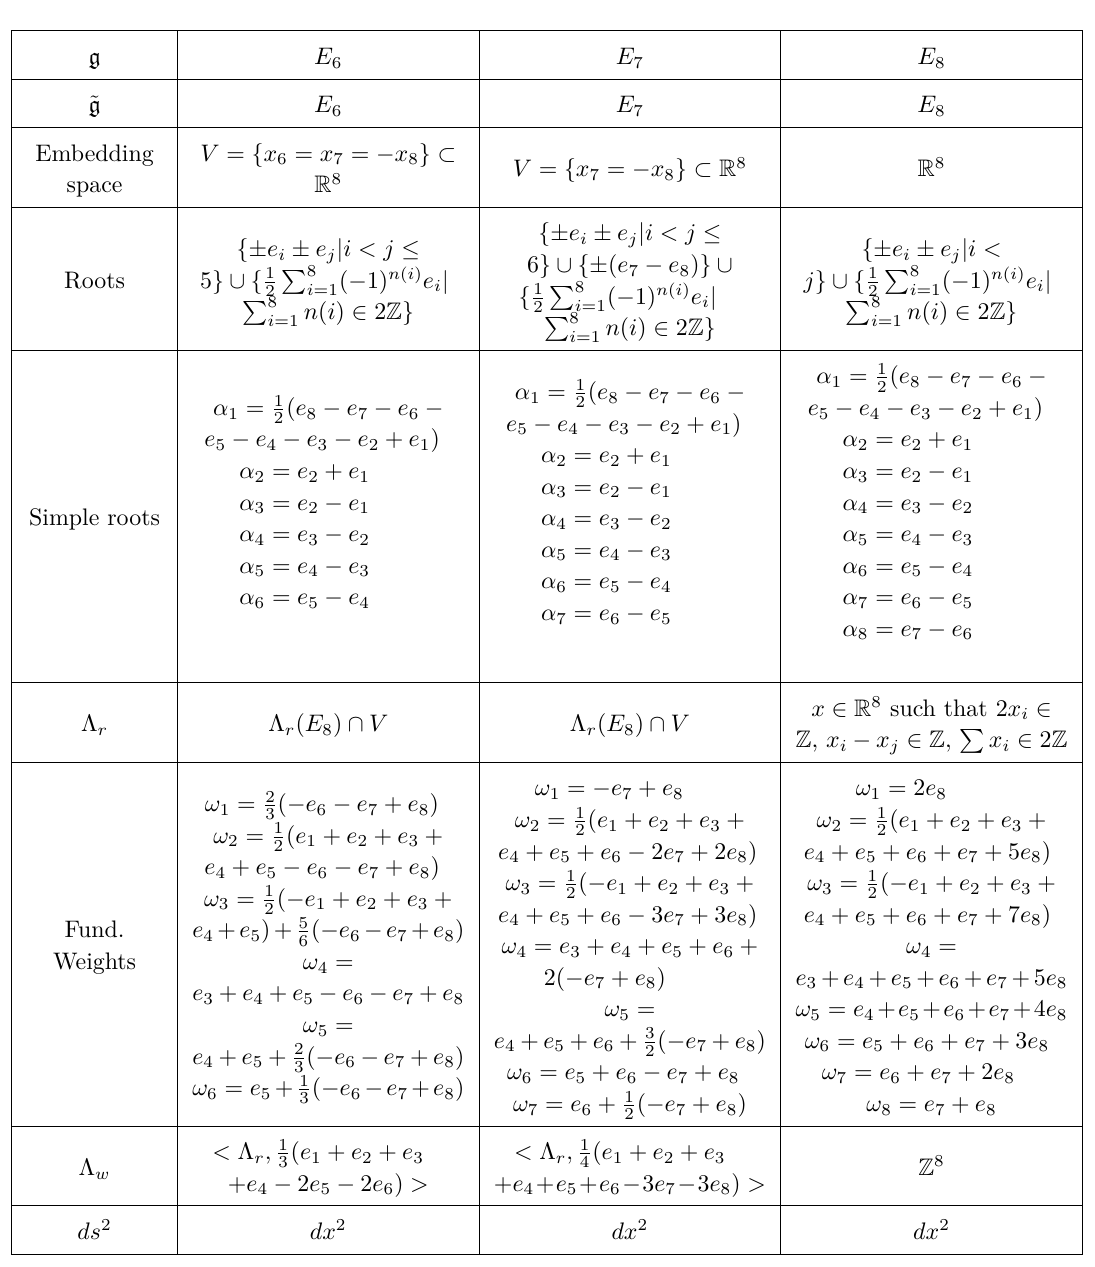
Table 8 . Description and properties of the E type root